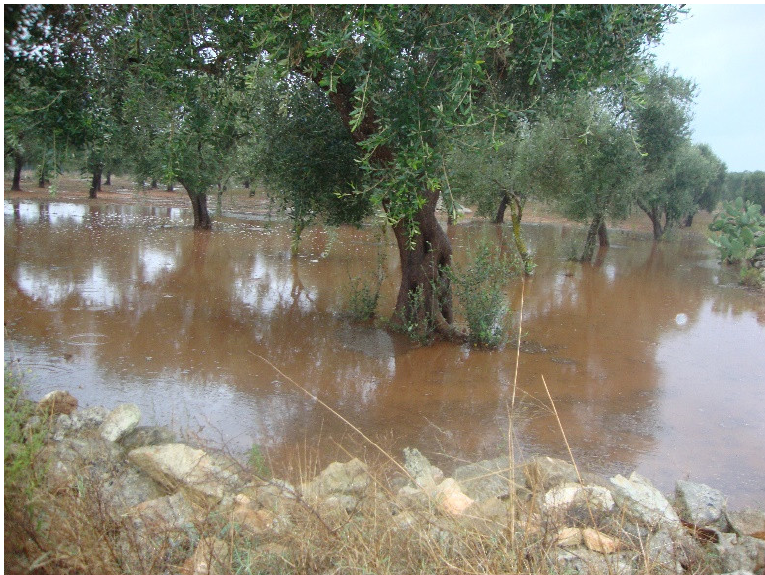
Figure 5. Waterlogging in an olive grove of Salento due to a relative excess of precipitation occurring over a short time. This situation occurs quite frequently in recent years due to climate change. Prolonged anaerobic conditions in the soil can occur, causing deleterious effects to the root system of the trees.